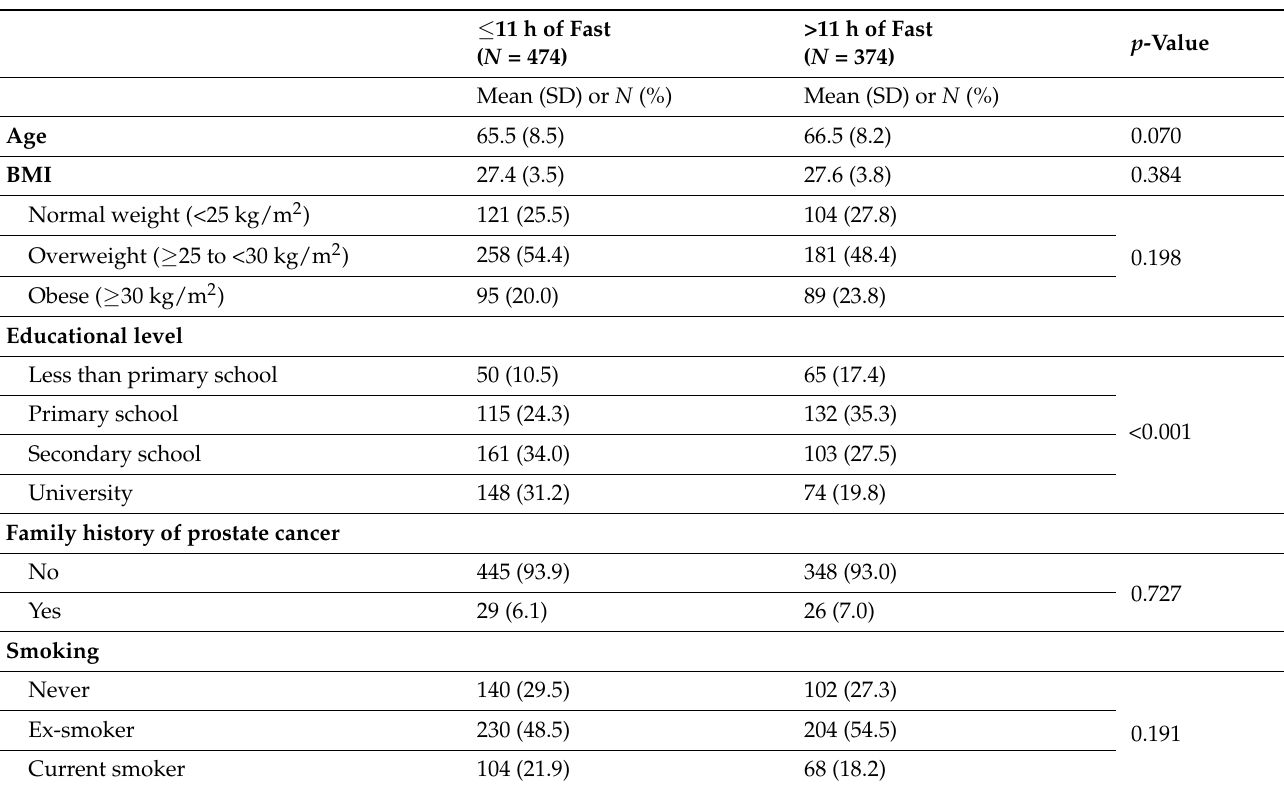
Table 2. Distribution of prostate cancer risk factors according to nighttime fasting duration in